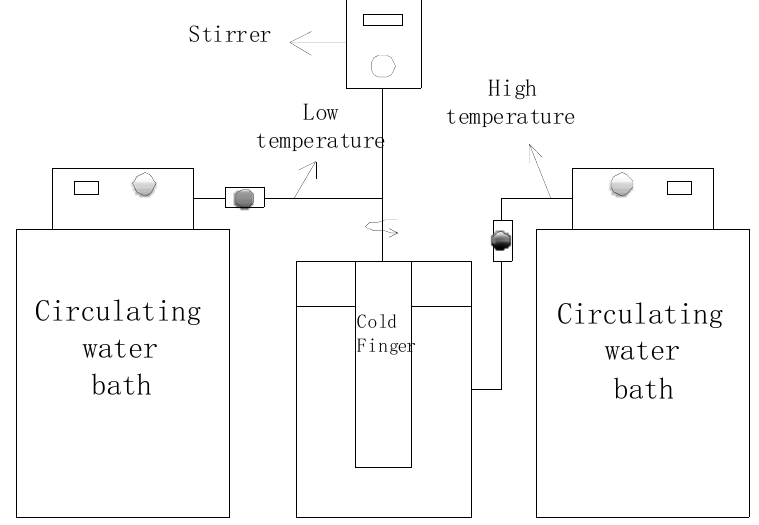
Figure 1. Schematic diagram of the device of cold